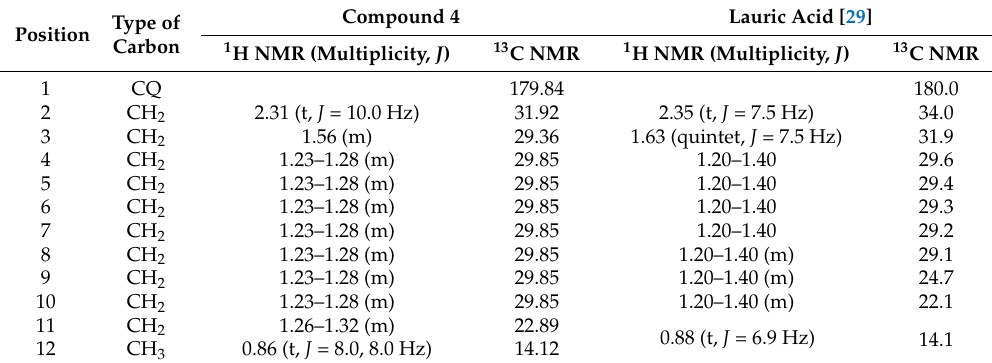
Table 3. 1 H and 13 C NMR Spectral Data Assignment of Compound 4 from C. sexangularis leaf.